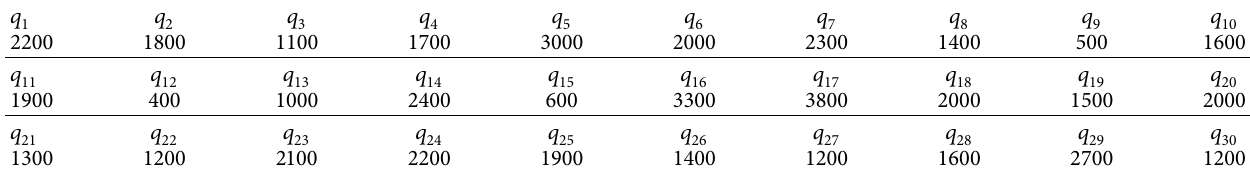
Table 1: Quantity demand of each front warehouse (kg).